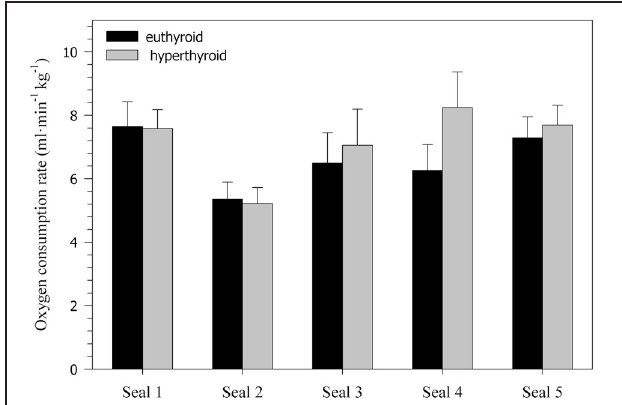
FIGURE 2 | Oxygen consumption rates (ml · min − 1 · kg − 1 ) during diving in five euthyroid and hyperthyroid seals (values are means ± SD; n = 10 trials per seal and condition).